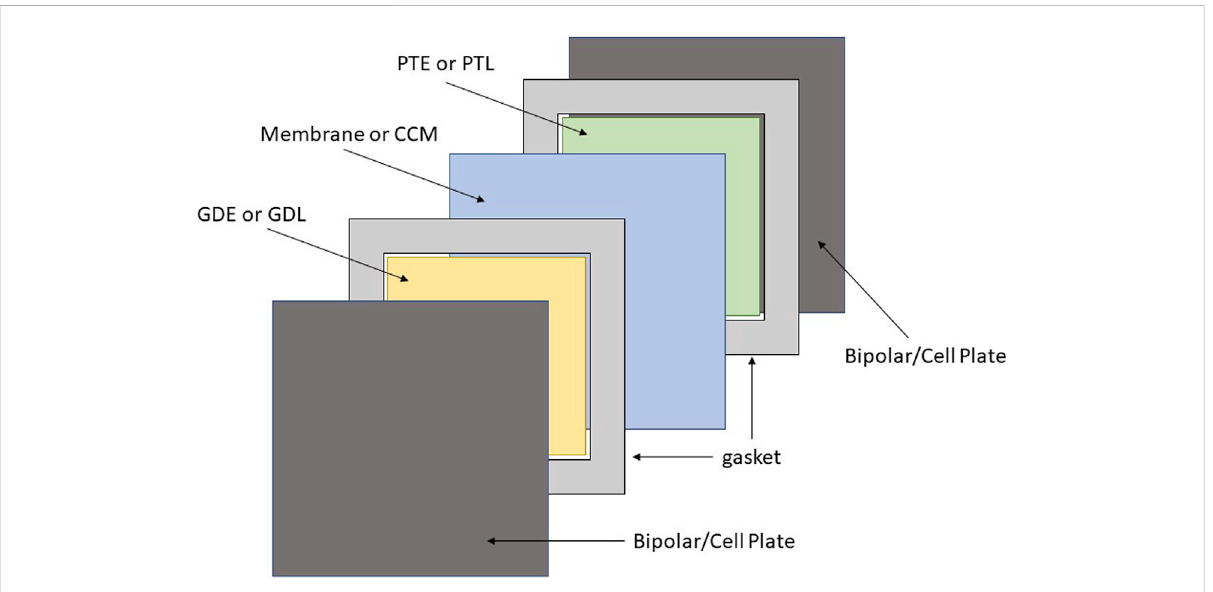
FIGURE 1 Illustration of the cell components including bipolar/cell plate, gaskets, GDE or GDL, Membrane or CCM, and the PTE or PTL displayed in dark grey, light grey, yellow, blue and green